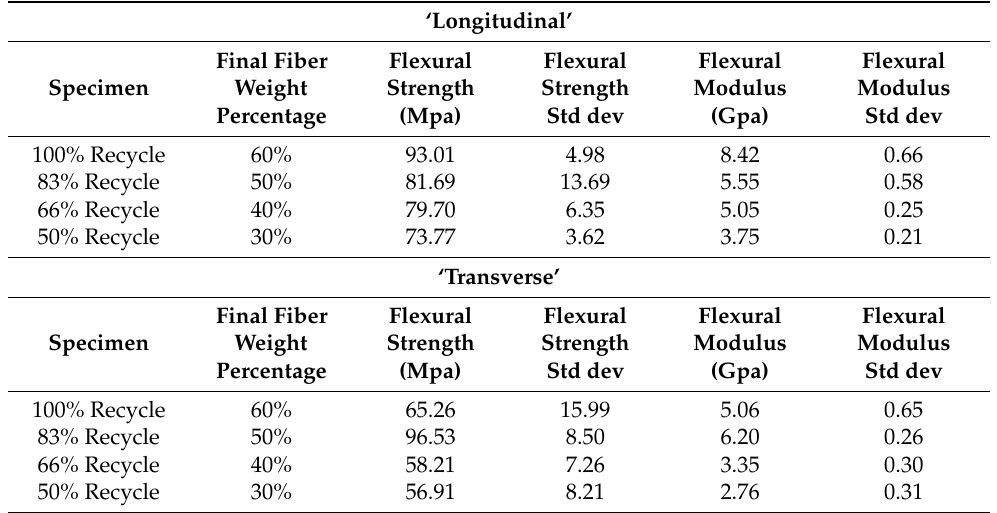
Table 4. Summary of flexure tests for various recycled fiber contents for ‘Longitudinal’ and ‘Trans- verse’,